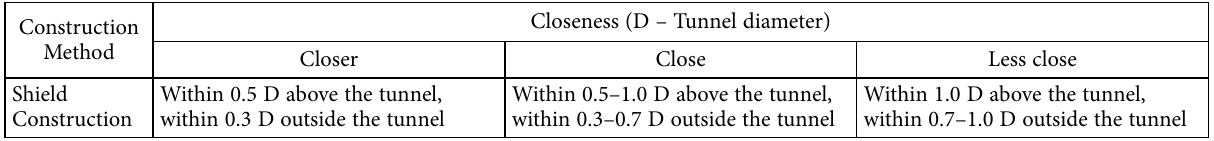
Table 2. Discrimination of closeness for environmental facilities and subway